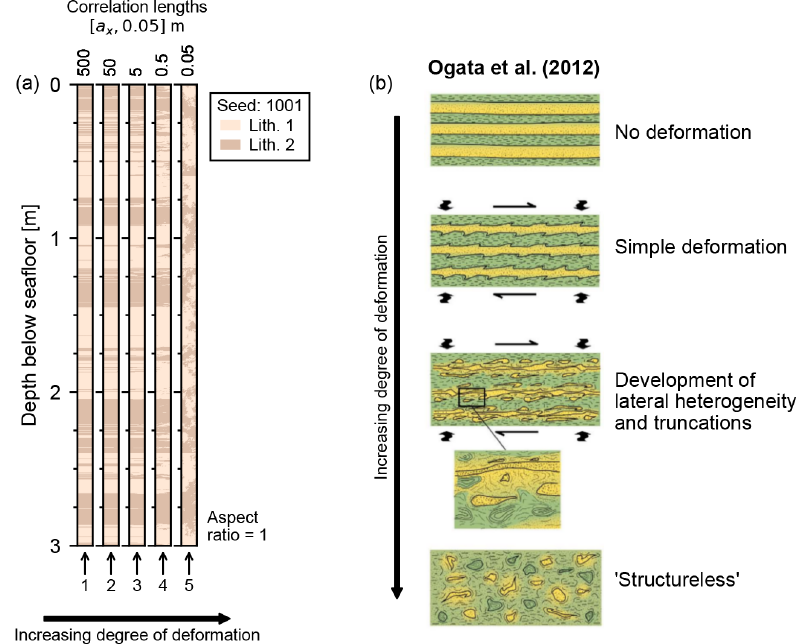
Figure 7. (a) Virtual cores from the mass-transport deposit zone in the multi-source synthetic experiment (Fig. 5), with fixed vertical cor- relation length and progressively decreasing lateral correlation lengths. (b) Conceptual cartoon model for progressive stratal disruption in a thin-layered, two-lithology sedimentary sequence, from unfailed, undeformed strata to a strongly deformed block-in-matrix-style fabric (modified from Ogata et al.,